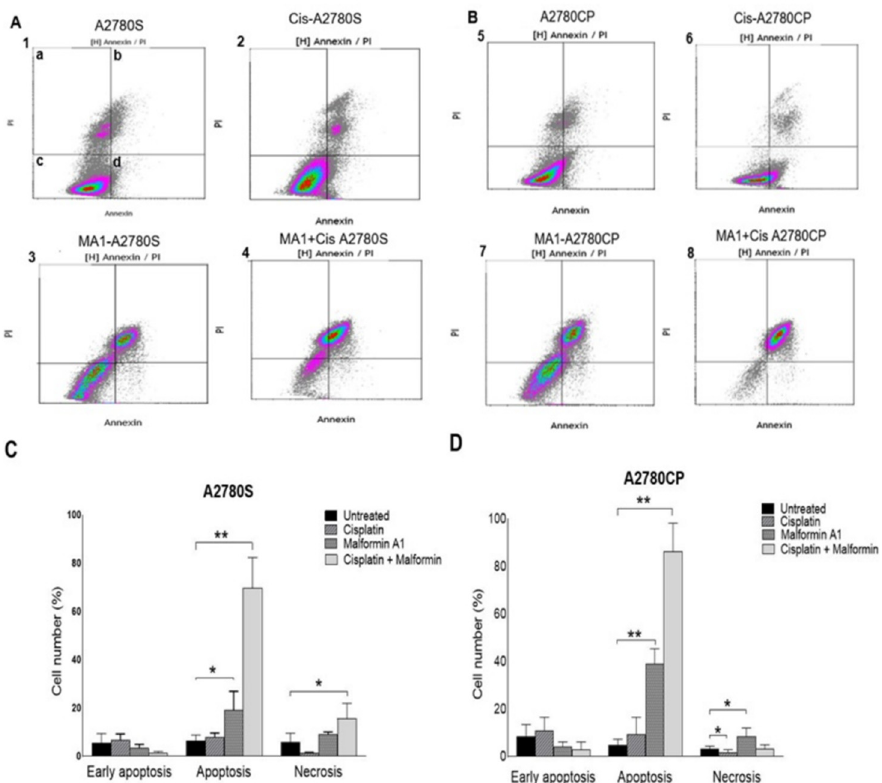
Figure 4. Flow cytometry analysis of A2780S and A2780CP cells after treatment with MA1 and cisplatin drugs. Effect of cisplatin and MA1 on A2780S cells ( A ), and A2780CP cells ( B ) assessed by flow cytometry. Ovarian cancer cells (5 × 10 5 ) were treated with cisplatin and MA1 at a concentration equal to their corresponding IC 50 . Cells were treated with cisplatin (A2 and B6), MA1 (A3 and B7), or both (A4 and B8) for 24 h. Cell death was determined by flow cytometry using PI and Annexin dyes. (d) The number of early apoptotic cell deaths (annexin-V positive cells with PI negative), and (b) the late apoptotic cell deaths (annexin-V and PI-positive). (a) The number of necrotic cells (PI-positive, annexin-V negative). The percentage of proapoptotic, apoptotic, and necrotic ( C ) A2780S and ( D ) A2780CP cells after treatment with IC 50 of cisplatin and Malformin A1 for 24 h. The results are presented as mean + SE of three independent experiments. * p < 0.05, ** p < 0.001.